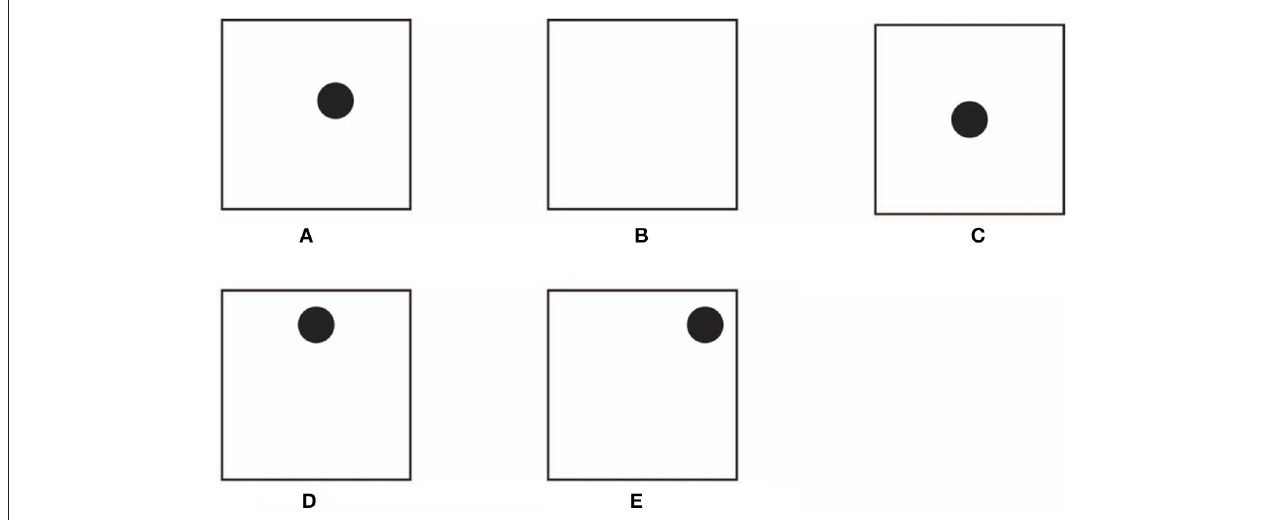
FIGURE 1 | The role of the center of a figure in Arnheim’s theory (A–C). The disk heightens and accentuates different components of the square (D–E)